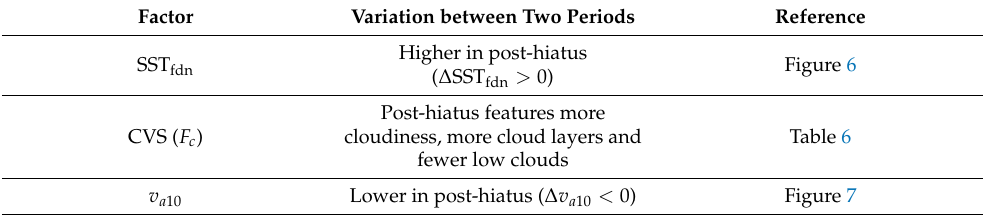
Table 7. Trend of probable factors in the hiatus and post-hiatus